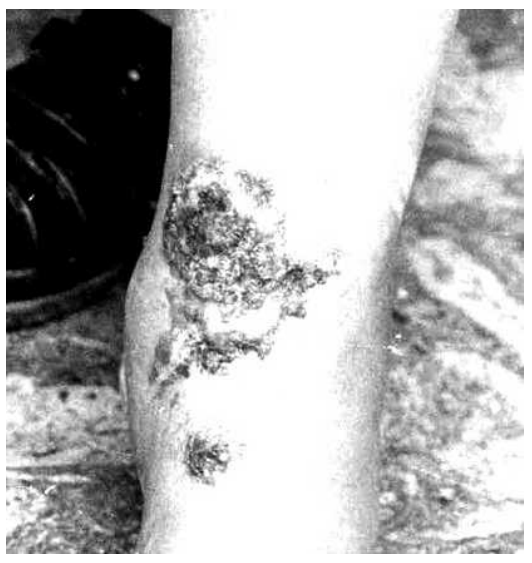
Fig. 3. – Inflammatory lesion of cutaneous leishmaniasis (Focus of Aïn Jloula).